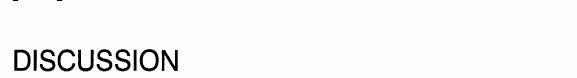
FIG. 9. Drawings of a person and a house by two patients (I) before and (II) after chlorpromazine